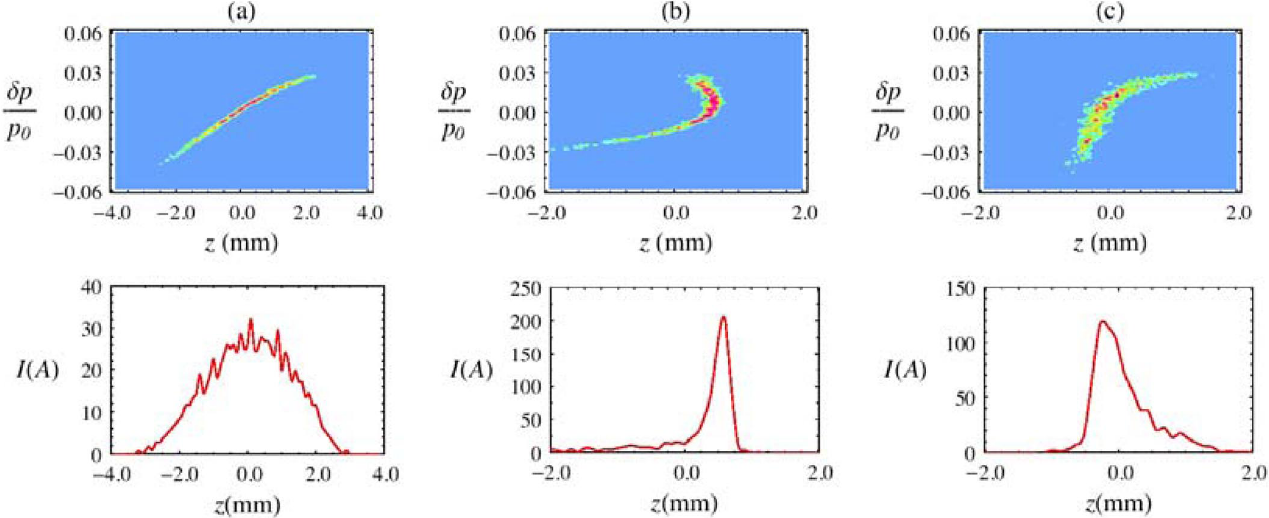
FIG. 3. (Color) Plots of the z trace space and current profile from PARMELA and ELEGANT simulations of the UCLA accelerator beam line showing (a) the beam at the entrance of the dogleg compressor, and the same beam at the end (b) without sextupole correction and (c) with sextupole